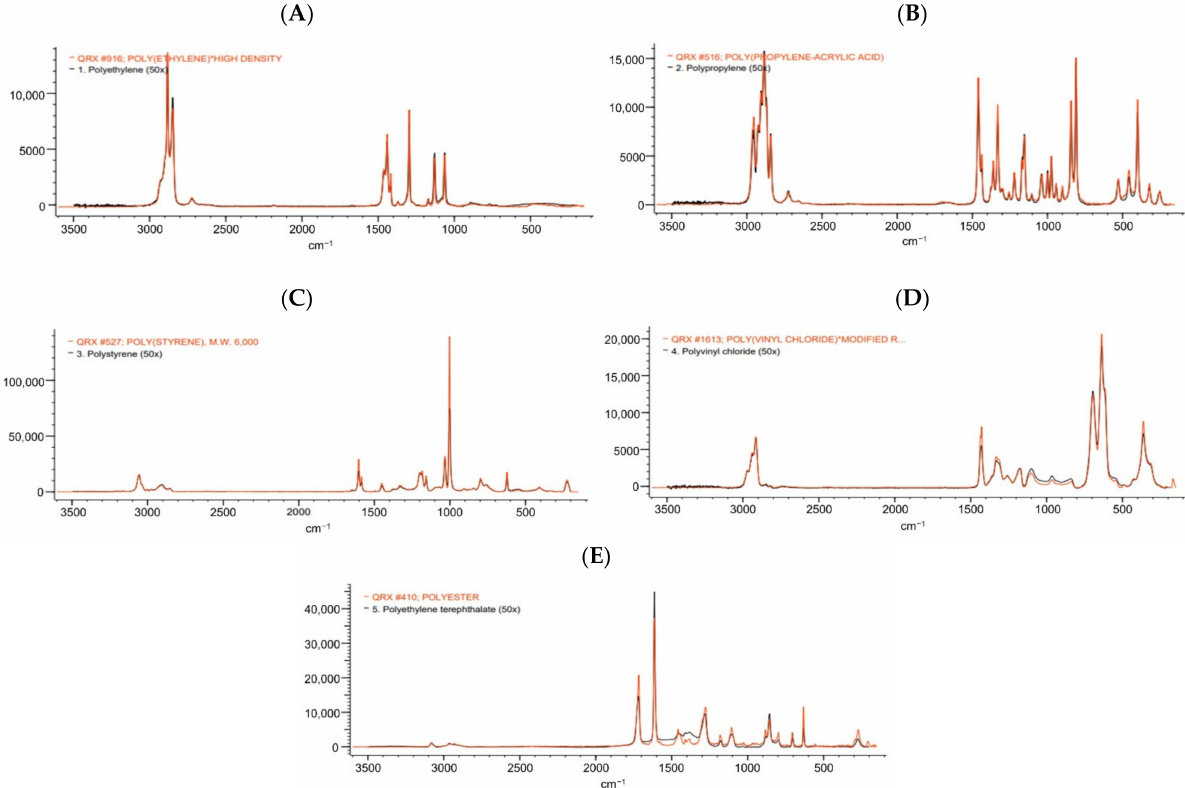
Figure 6. Raman spectra of polyethylene ( A ), polypropylene ( B ), polystyrene ( C ), polyvinyl chloride ( D ), and polyethylene terephthalate or polyester ( E ). The spectra taken for spiked plastic polymers that underwent the combined enzymatic– oxidative digestion are shown in black, while the reference spectra are shown in